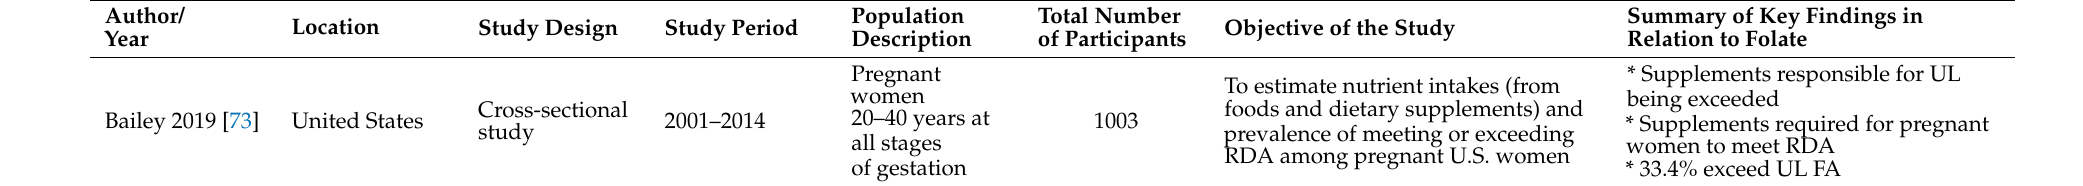
Table 2. Included studies sampling pregnant